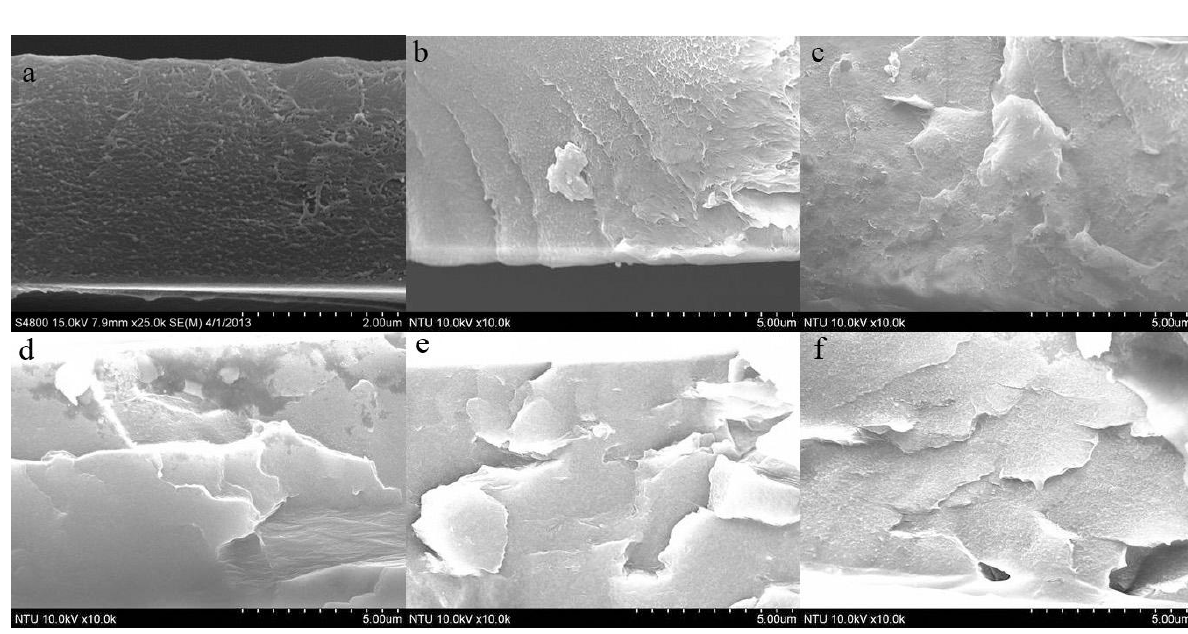
Figure 12. SEM pictures of the cross-sections of PVDF films whose GO-doping concentrations are: ( a ) 0 wt%; ( b ) 0.1 wt%; ( c ) 0.3 wt%; ( d ) 0.5 wt%; ( e ) 1.0 wt%; ( f ) 2.0 wt%,